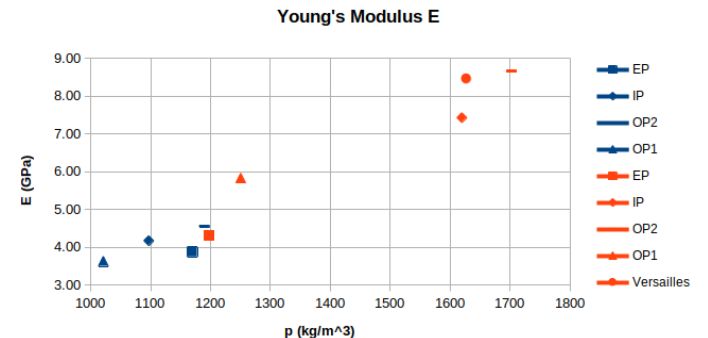
Figure 3. Young’s modulus as a function of density. Pure (blue) and composite (red) resins